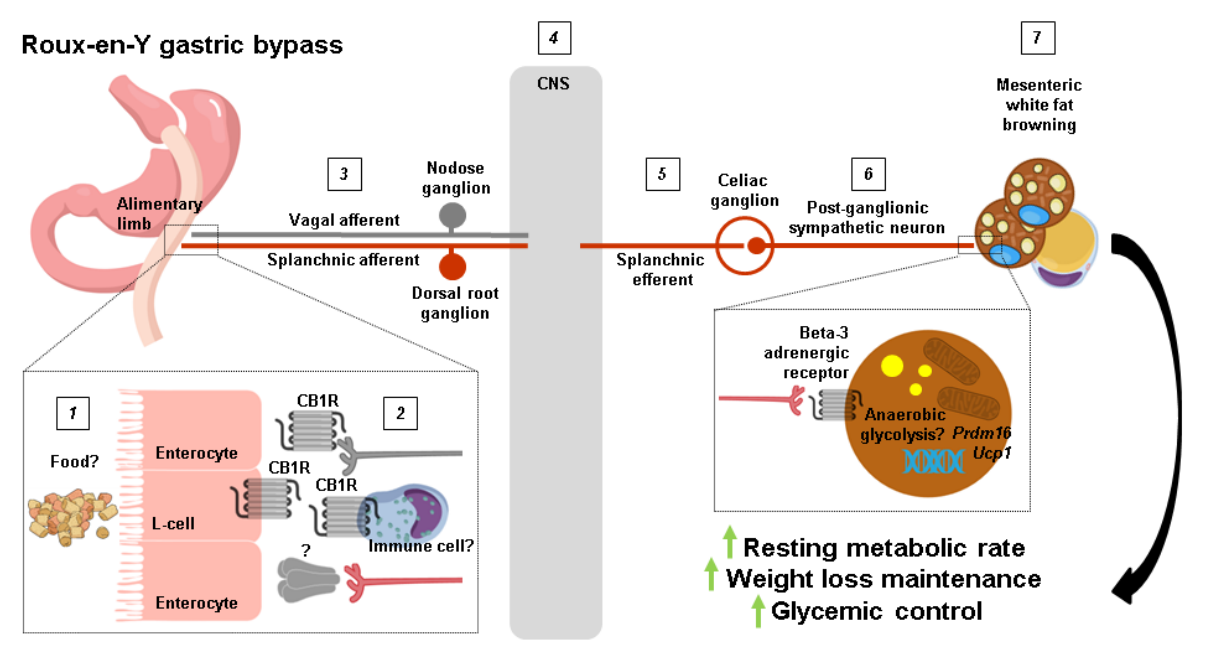
FIGURE 1: A proposed pathway for how RYGB increases resting metabolic rate. 1 The rerouting of ingested food caused by RYGB may 2 downregulate jejunal CB1 receptors in L-cells, peripheral vagal afferent endings, and/or immune cells. This would then result in 3 the in- creased excitability of vagal afferent and splanchnic afferent nerve fibers which propagate their signals to 4 the central nervous system where they are processed. Splanchnic efferent neurons are in turn 5 stimulated to 6 region-specifically increase sympathetic tone and 7 induce browning of mesenteric white fat. The ultimate outcome is an increase in resting metabolic rate which drives weight loss mainte- nance and improvements in glycemic